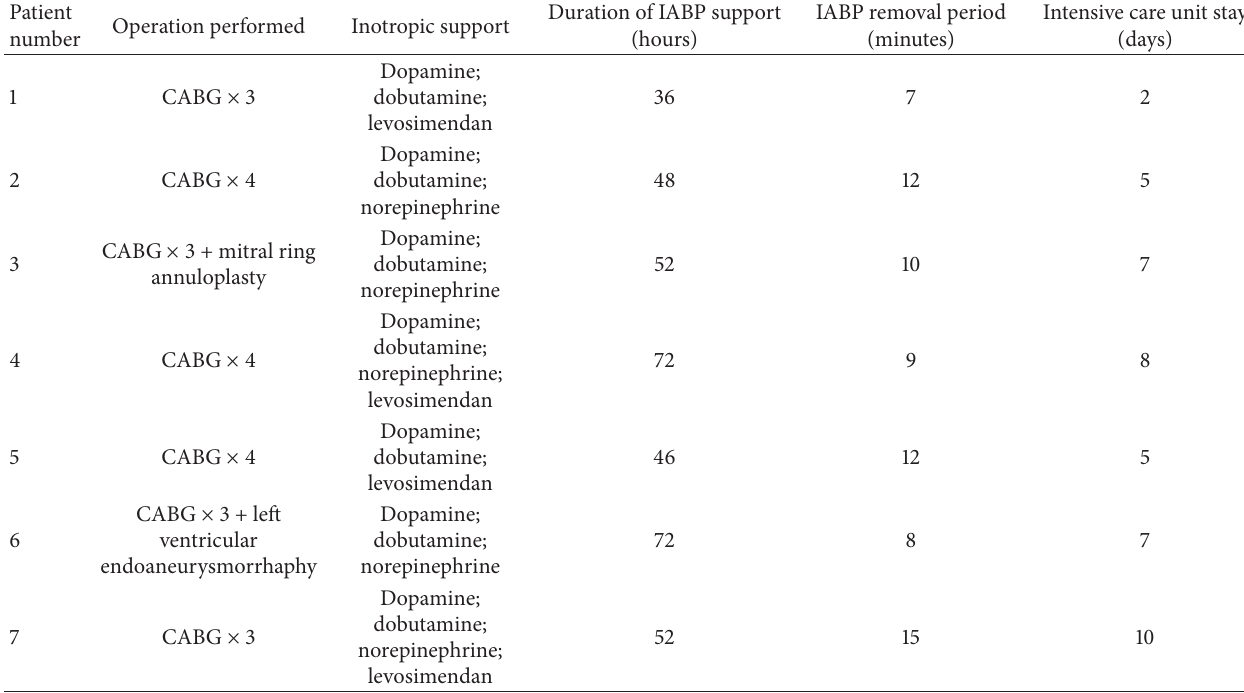
Table 2: Operative and postoperative data of the